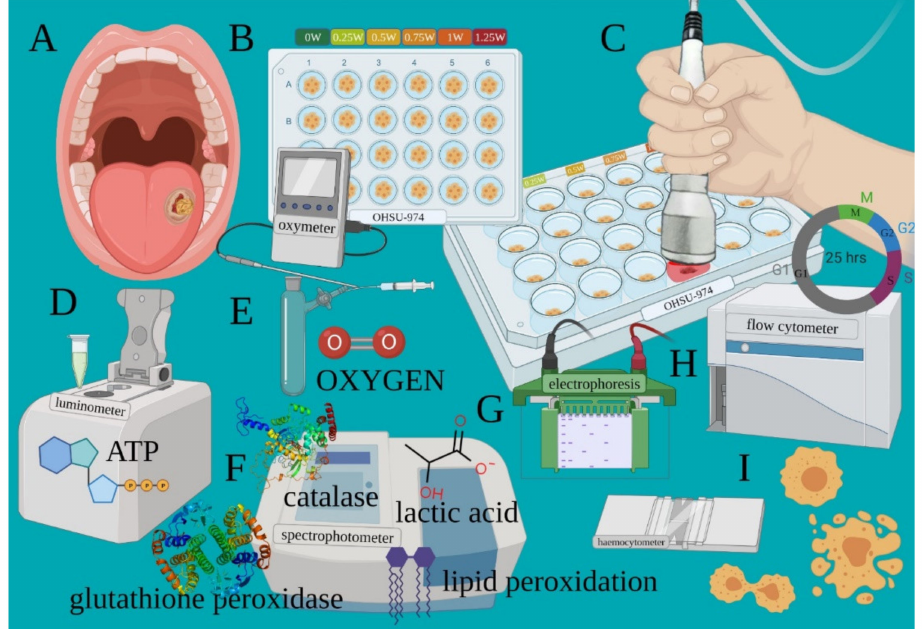
Figure 2. Experimental design outlining the various outcomes assessed after PBM treatments. Cancer cell line from human tongue squamous cell carcinoma ( A ) was transferred into a black 24 well plate with a flat and clear bottom ( B ). PBM therapy was administered through the 810-nm laser ( C ). After treatments, cells are processed to evaluate the variation of the energetic metabolism such as ATP synthesis ( D ), oxygen consumption ( E ), OxPhos efficiency, lactic acid production and oxidative stress ( F ). Markers regulating apoptosis ( G ) and cell cycle and viability ( H , I ) were also